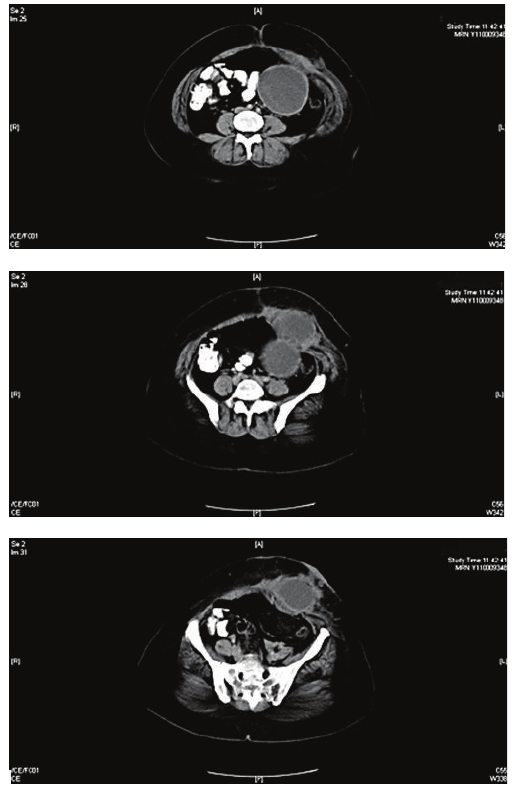
Figure 1: Three di ff erent views of computerized tomography show a mass formation extending to the abdominal wall.